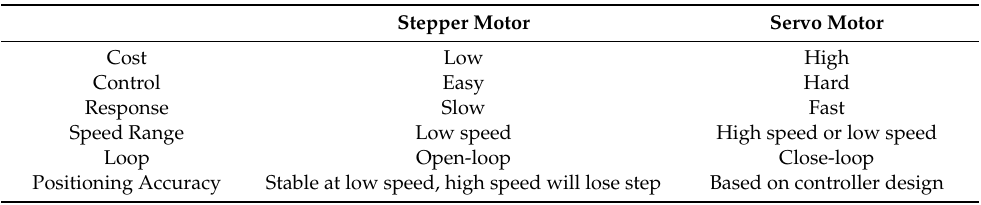
Table 2. Stepper motor and servo motor comparison